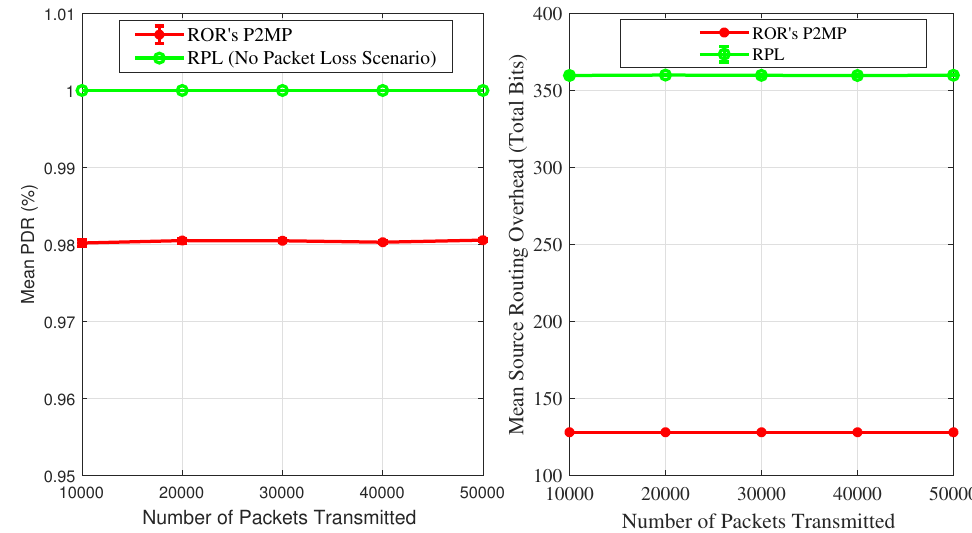
Figure 11. Performance